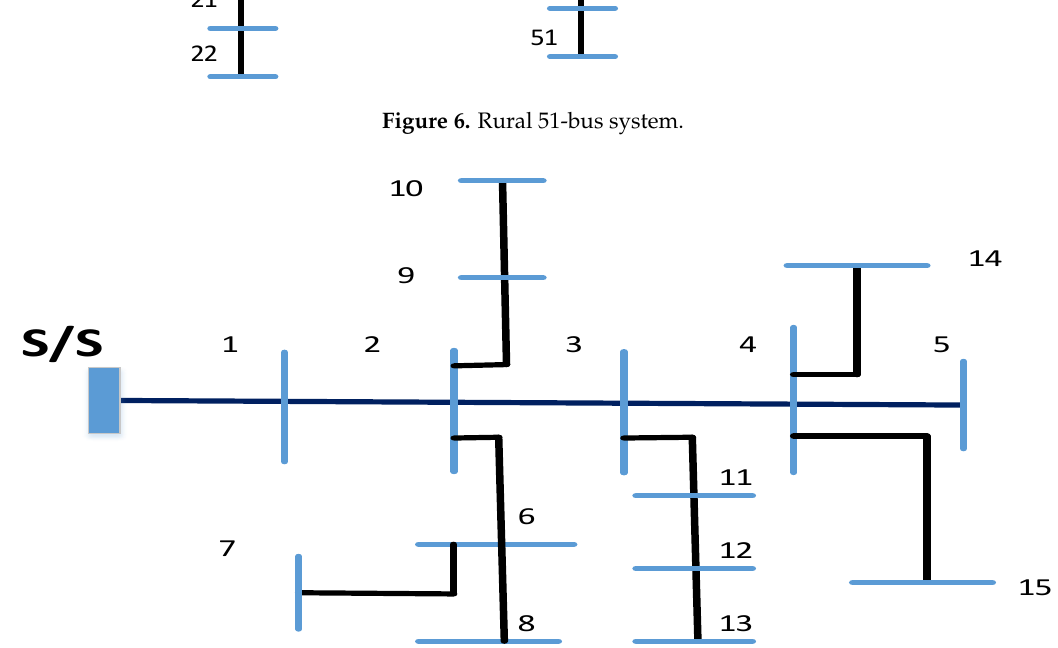
Figure 6. Rural 51-bus system.